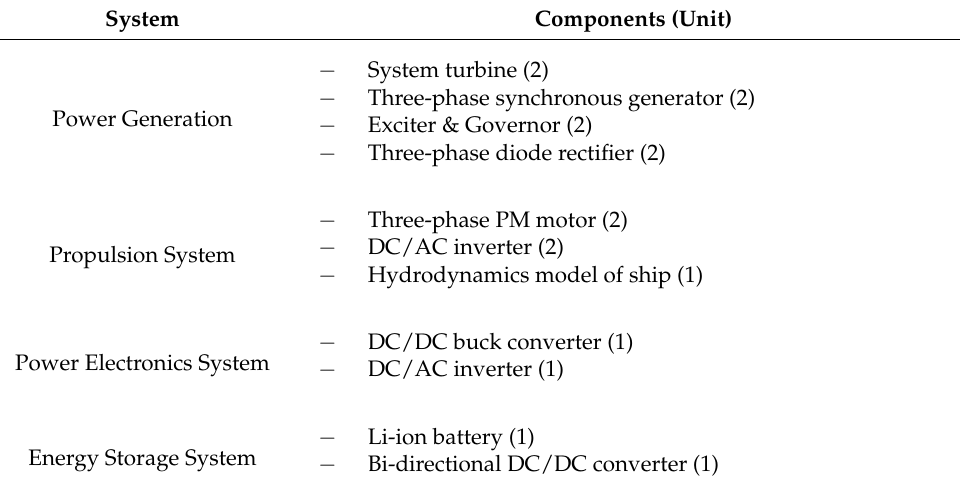
Table 1. Parameters of the simulation